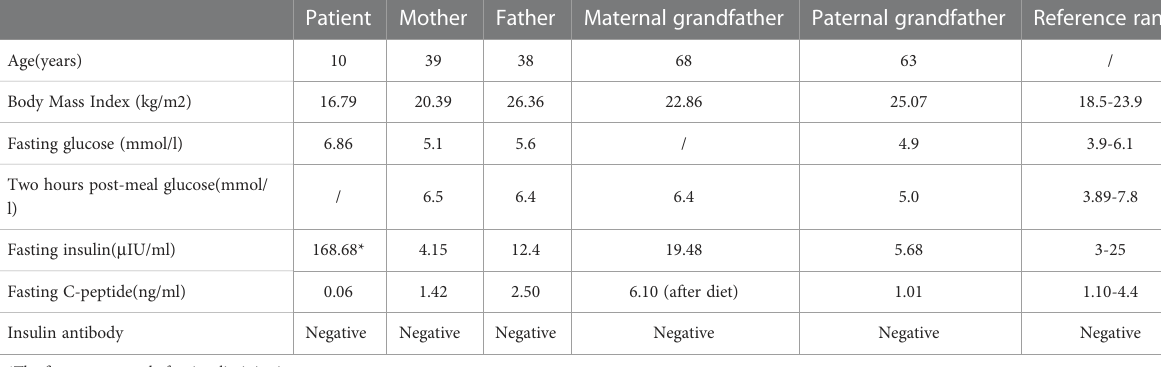
TABLE 2 Related examination results of family members